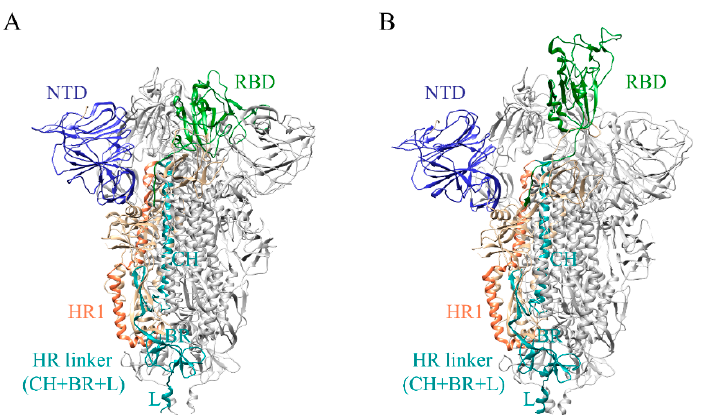
Figure 1. Schematic representation of SARS-CoV-2 S protein in ( A ) closed state (S closed , PDB ID: 7DDD) and ( B ) open state (S open , PDB ID: 7DDN). N-terminal domain (NTD), receptor-binding domain (RBD), heptad repeat1 (HR1), and HR linker were colored by blue, green, coral, and dark cyan, respectively.